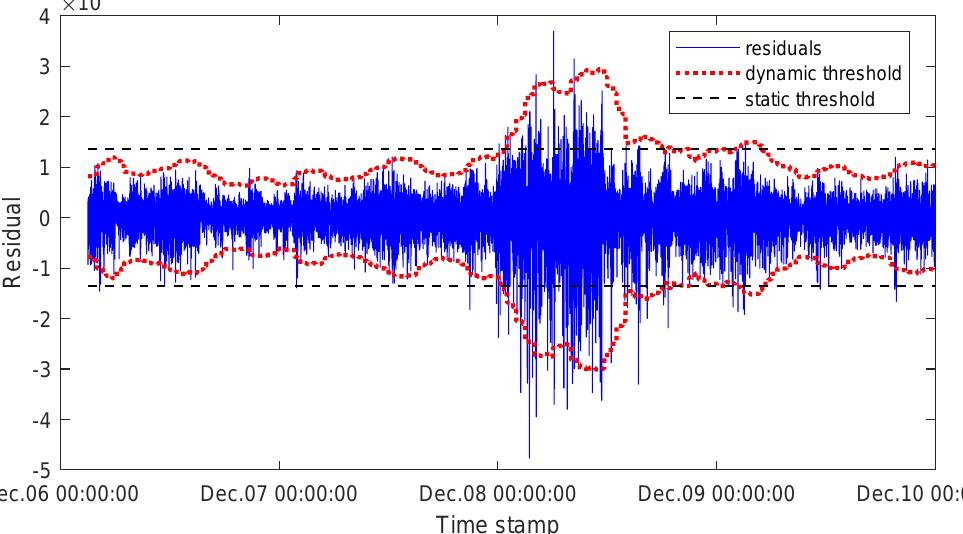
Figure 12. Monitoring results of the validation residuals under the dynamic threshold scheme and the static threshold scheme.